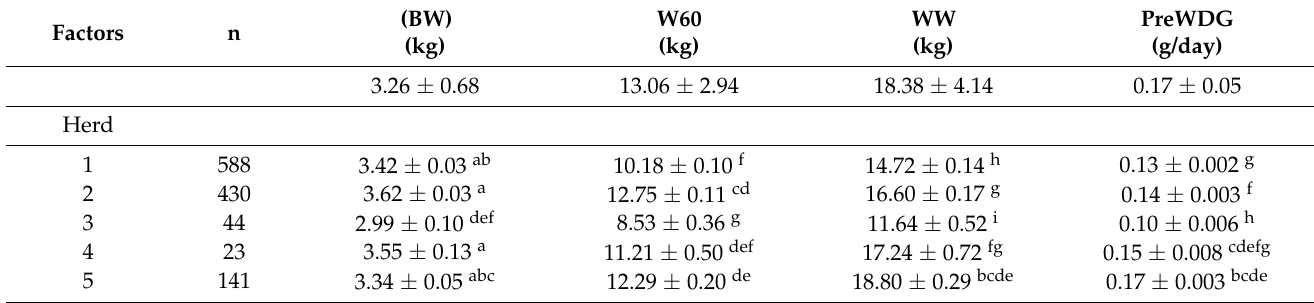
Table 2. Analysis of variance of non-genetic affecting growth traits in Turkish Saanen